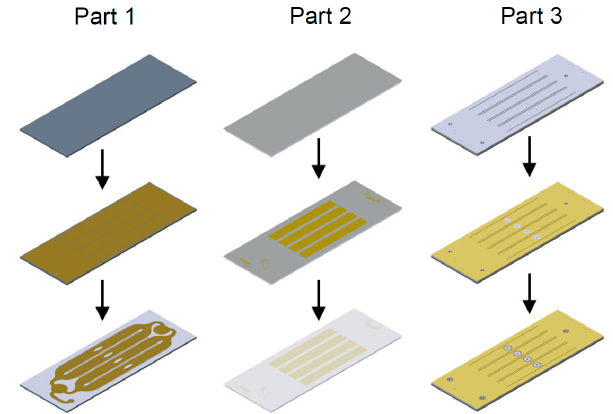
Figure 5. Completed SU-8-based free-standing impedance spec- troscopy sensors with different designs on a 100mm substrate.